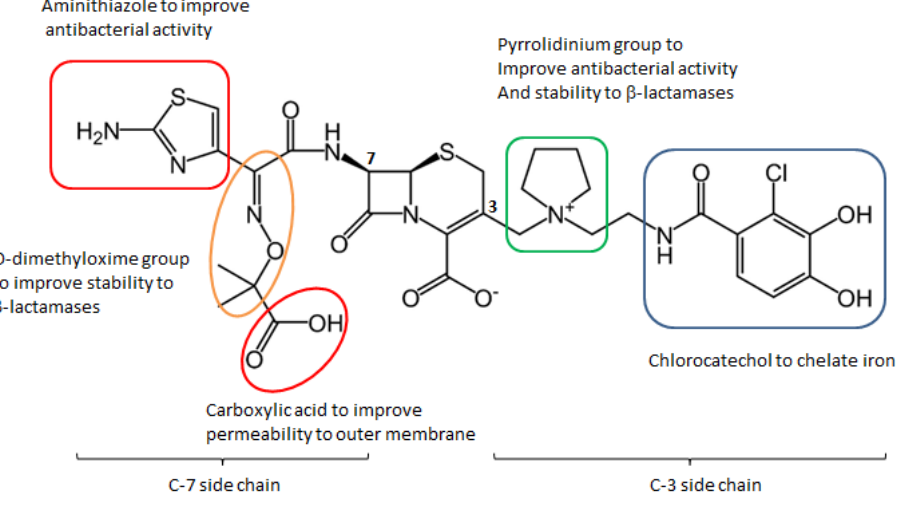
Figure 10. Cefiderocol: structure–activity relationships (SAR).